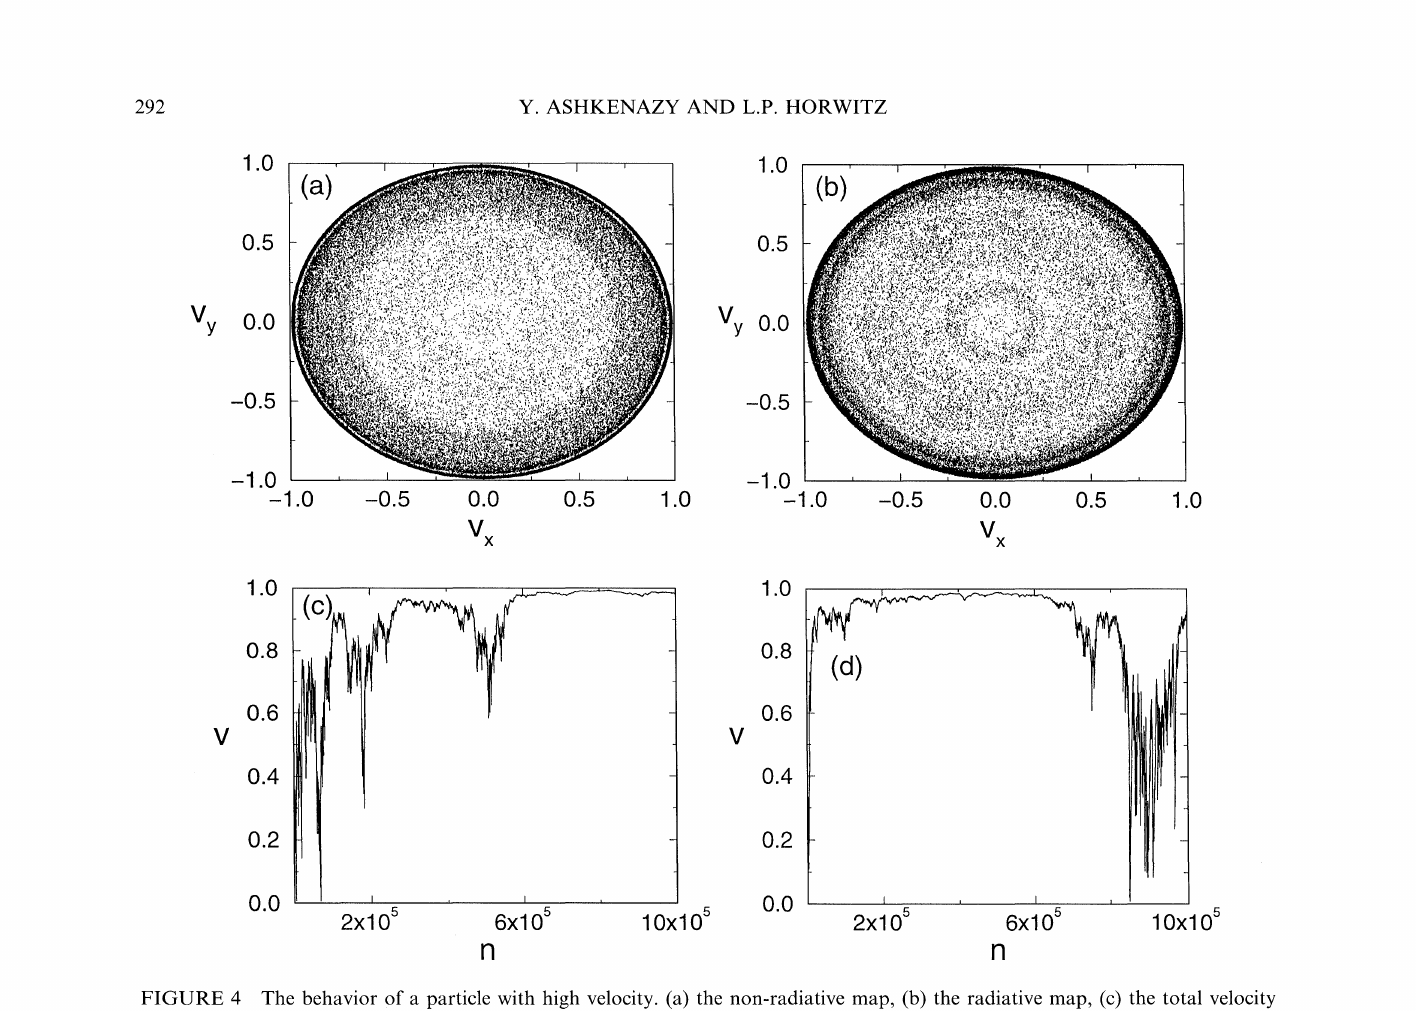
FIGURE 4 The behavior of a particle with high velocity. (a) the non-radiative map, (b) the radiative map, (c) the total velocity of the non-radiative case, and (d) the total velocity of the radiative